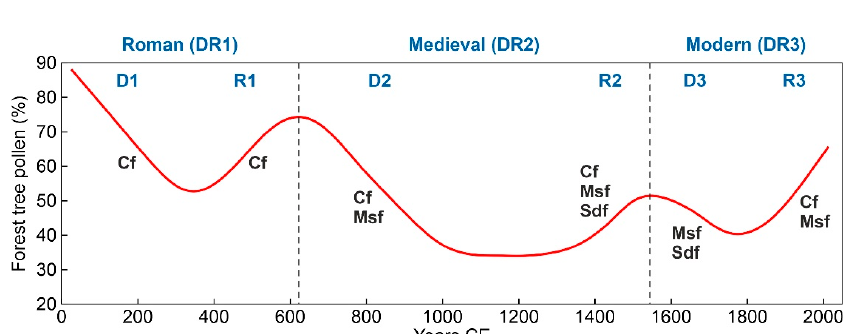
Figure 6. Forest pollen groups considering the forest types defined with the cluster analysis (Figure 5) coincide with present-day forest associations. Black dots: raw data, red line: smoothing spline. Conifer forest (Cf): Pinus ; Mediterranean sclerophyll forest (Msf): evergreen Quercus ; Submontane deciduous forest (Sdf): deciduous Quercus , Betula , Fagus and Corylus ; Riverine forest: Alnus , Salix and Ulmus .